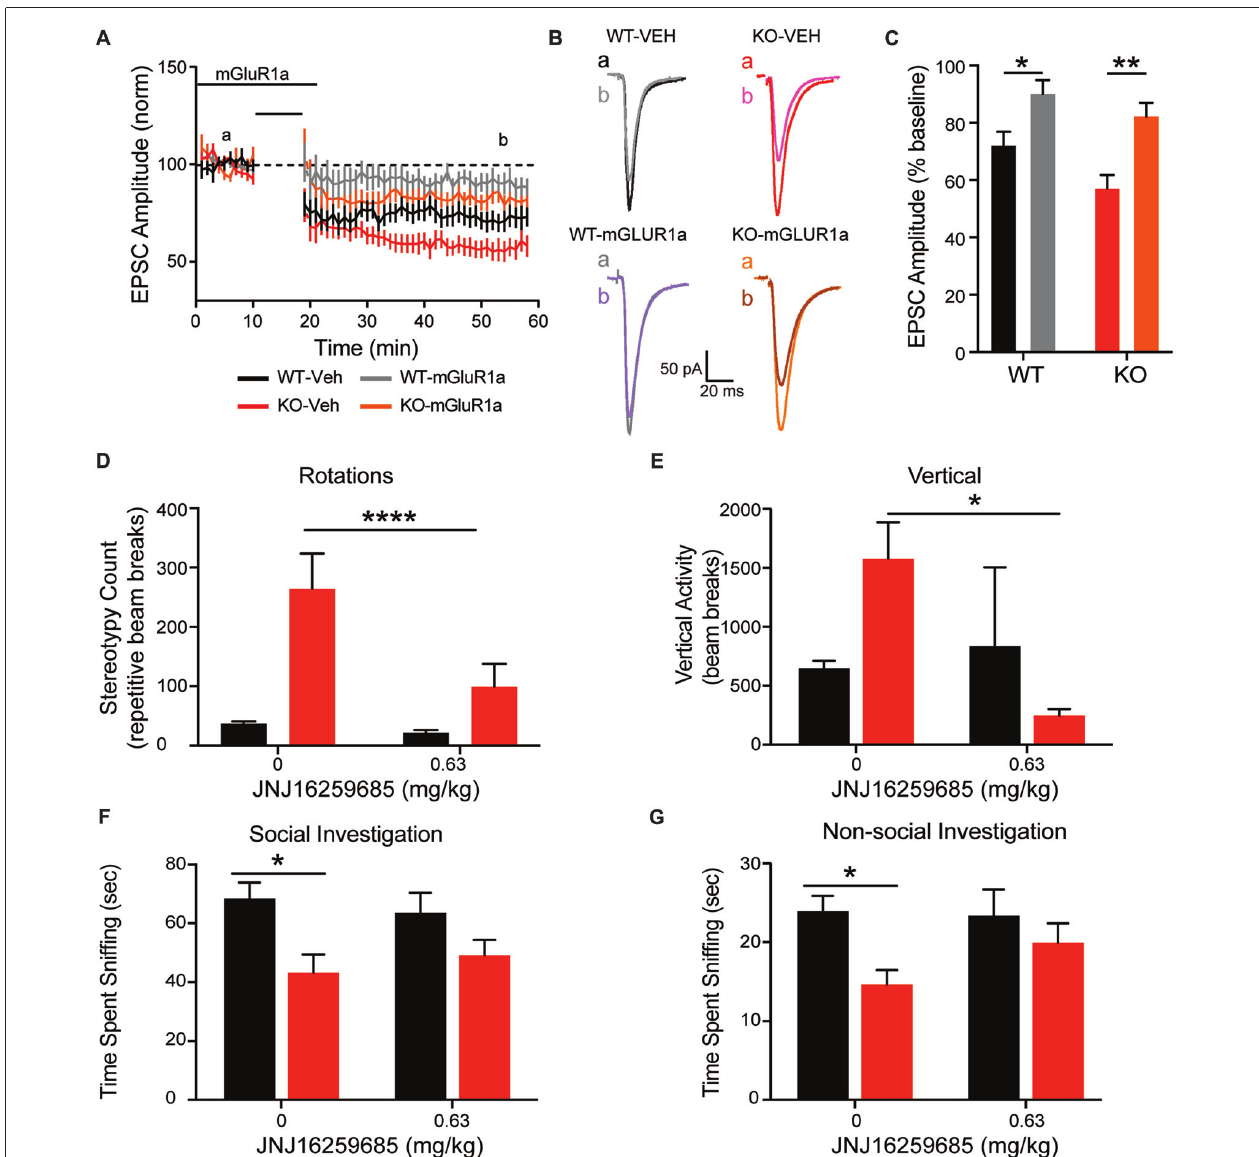
FIGURE 9 | mGluR1 antagonist JNJ16259685 rescues both striatal physiology and behavior. Administration of the selective mGluR1 antagonist JNJ16259685 normalizes the enhanced striatal LTD response of the KO animals (A) . Traces are representative EPSPs from the indicated time periods (B) . Treatment significantly reduced the depression in both WT and KO rats (C) . Blocking mGluR1 receptors in vivo selectively rescues the striatally mediated stereotypic behaviors, including rotations (D) and rearing (E) , but does not have an effect on social (G) or non-social (F) investigation. In all panels WT animals are in black and KO animals are in red. Note the data in (A) for vehicle WT and KO data (black and red lines, respectively) are also depicted in Figure 7A . Bars indicate SEM. ∗ p < 0.05, ∗∗ p < 0.01, ∗∗∗∗ p <